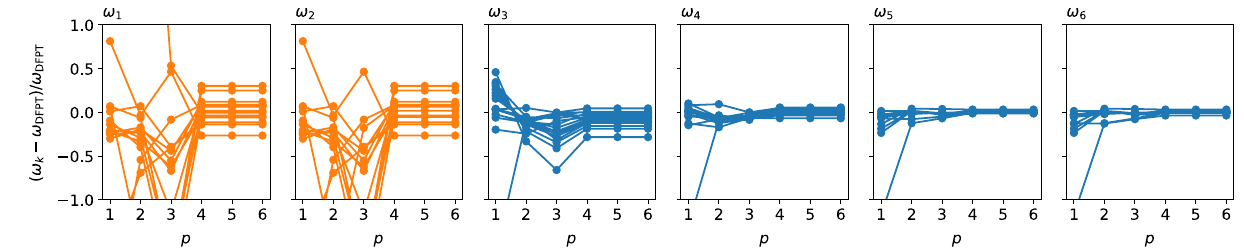
Figure 3. The variation of the relative error of the M point phonon energies between the p NN models and the DFPT for the 15 Cu-based